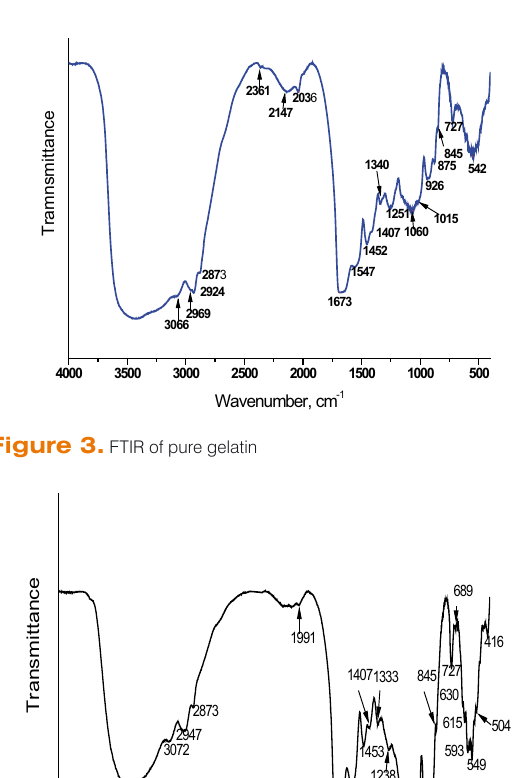
Fig. 3 represents the FTIR spectrum of pure gelatin, the organic part of the hybrids.